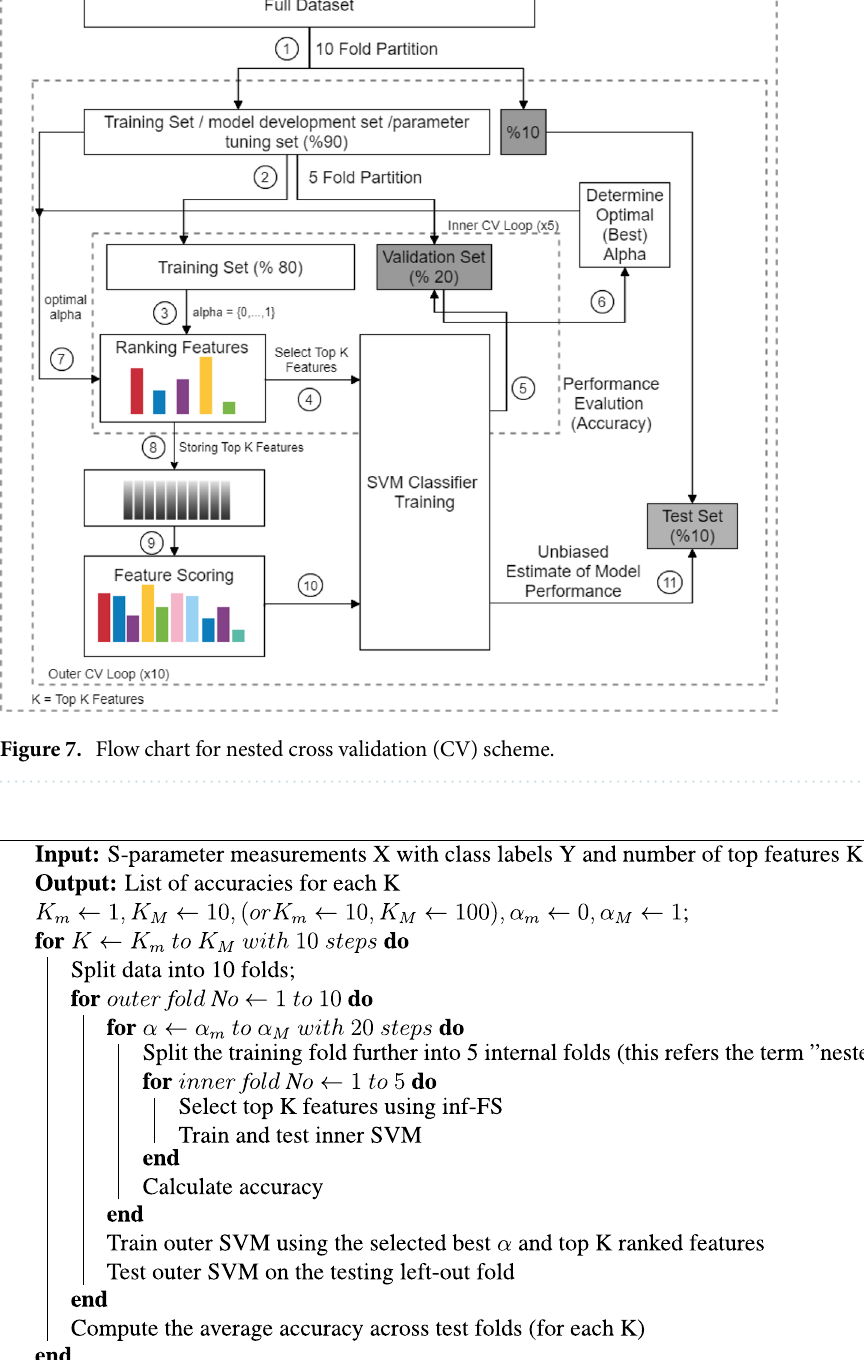
Figure 8. Algorithm of nested cross validation